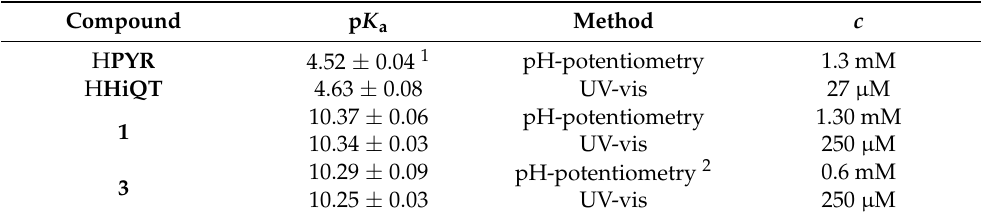
Table 3. p K a values of ligands H PYR and H HiQT and chlorido complexes 1 and 3 in pure water in the presence of 200 mM chloride ions. { T = 25.0 °C, I = 0.2 M KCl}.